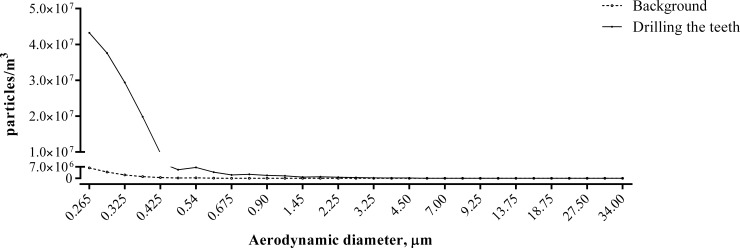
Particle size distributions of drilling the teeth and non-drilling the teeth in non-suction conditions.